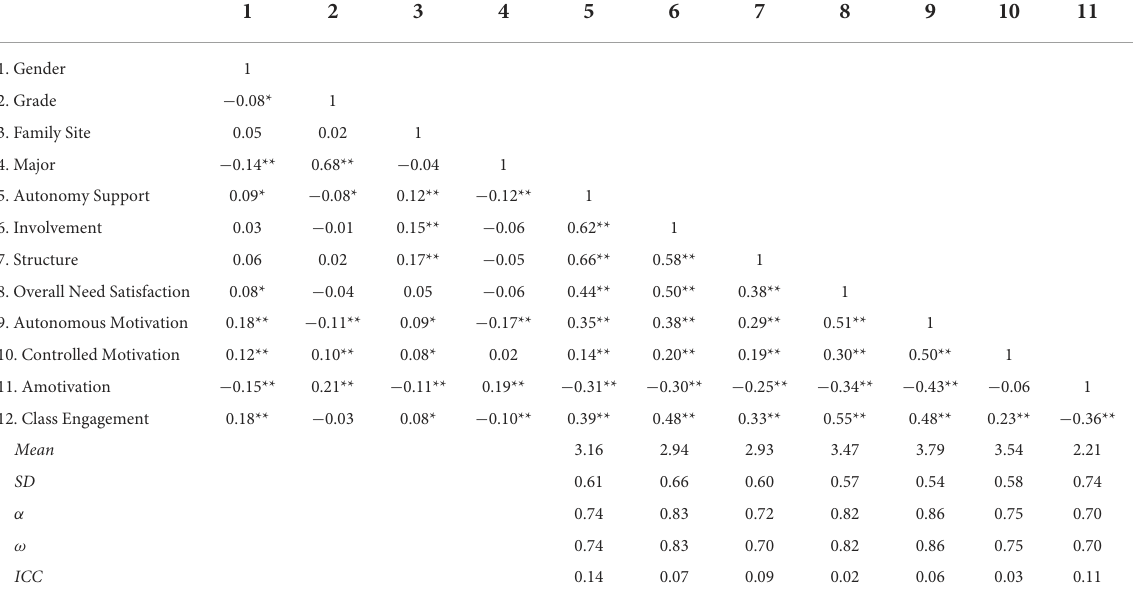
TABLE 2 Descriptive statistics, ICC, and correlations among the study